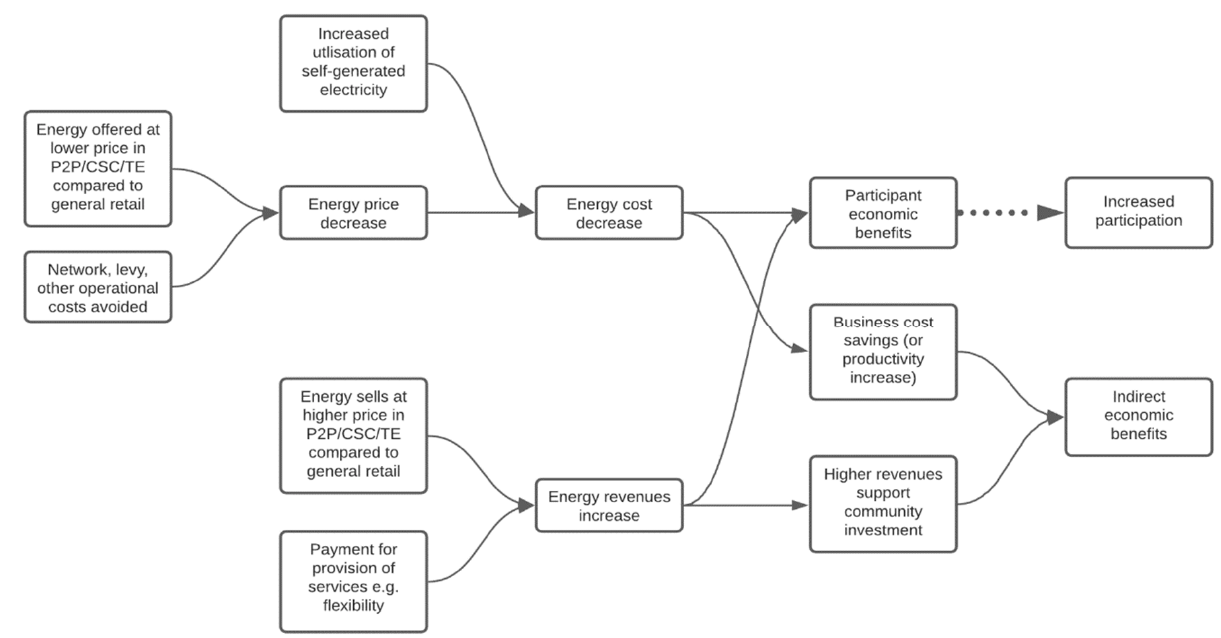
Figure 6. Elements of economic value as revealed in this review. The arrows represent our interpretation of how they are likely to relate to each other. The dotted line represents mixed evidence in support of this connection.